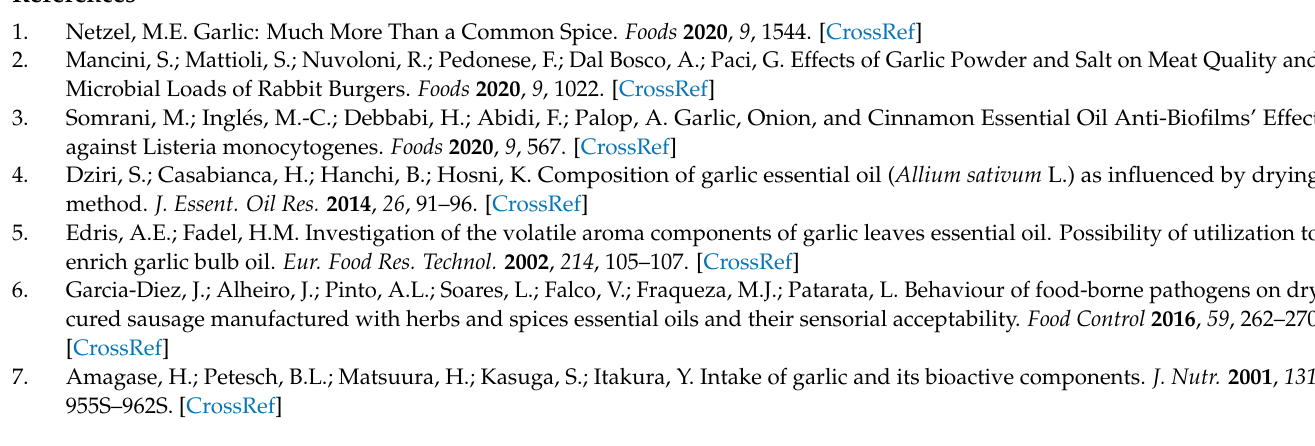
scanning microscopy of laser results. Figure S4: Droplet size distributions of the freshly prepared GEO and GEO-VO emulsions (A, C and E) and the emulsions after standing for 12 h (B, D and F). Figure S5: FTIR spectra of GEO and GEO-VO microcapsules. Figure S6: TGA curves of GEO and GEO-VO microcapsules. Table S1: The experimental design for preparing GEO and GEO-VO emulsions. Table S2: Volatile compounds of corn oil, soybean oil and olive